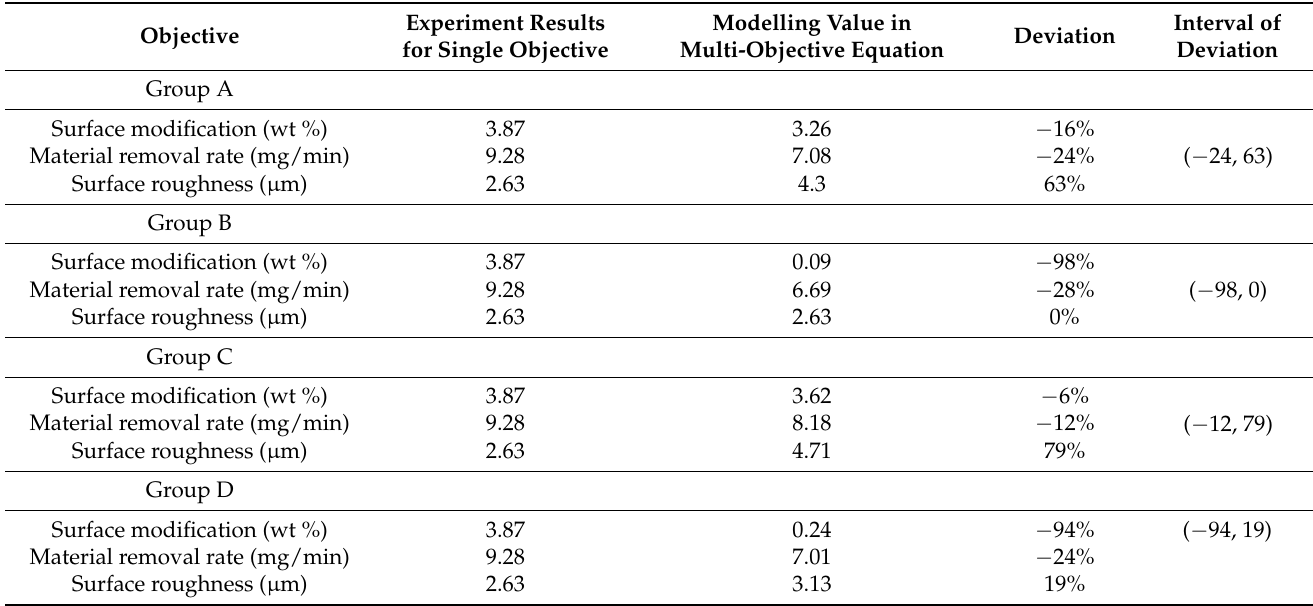
Figure 16. Scanning results: ( a ) performance of multi-objective optimization for each control interval and extreme values at ( b ) A point; ( c ) C point; ( d ) B point; ( e ) D point. Table 6. Comparison of multi-optimization results with optimal combinations for single objectives.